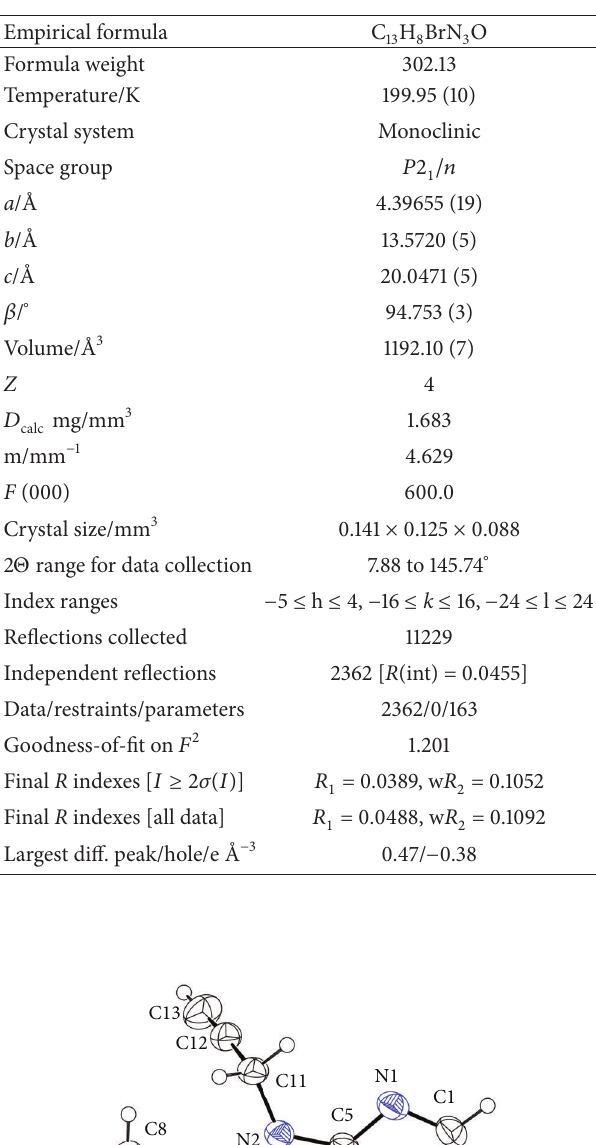
Table 1: Crystal data and structure refinement for compound 1 .